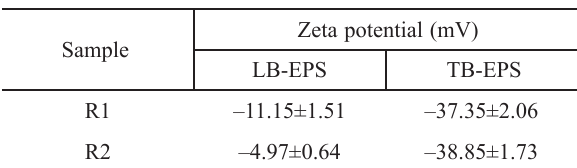
Table 3 – Zeta potential of LB-EPS and TB-EPS in reactors R1 and R2